Question: What does this figure show? Answer in one sentence.
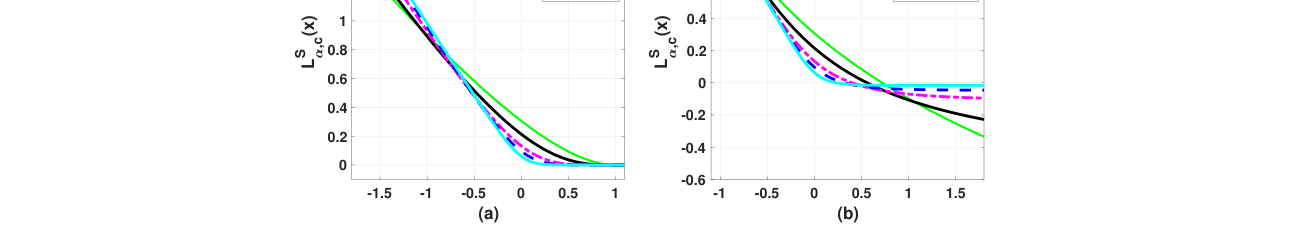
Answer: Graphs of the virtual SIGTRON-induced loss function LS α,c for (a) α = k−1